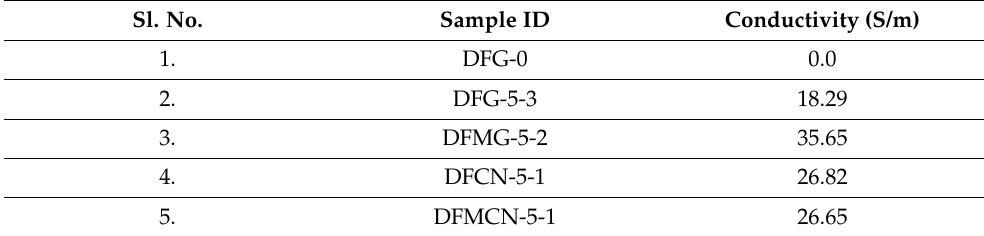
Table 5. Electrical conductivity of the prepared MWCNT/GNF-PVDF nanocomposite samples. Sl. No.